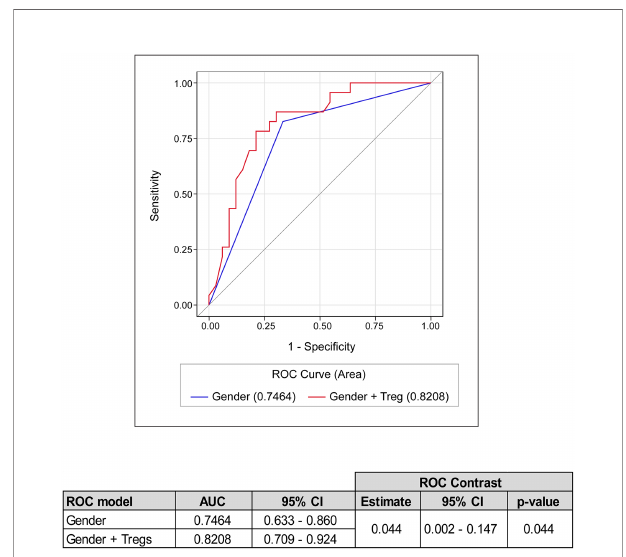
FIGURE 4 | ROC curve selection analysis. ROC analysis for the discrimination of improved and worsened clinical course during hospitalisation. The best individual discriminator (i.e., gender) and the best combination (i.e., gender + Tregs) are reported. AUC, Area Under the ROC Curve; 95% CI, 95% CI con fi dence